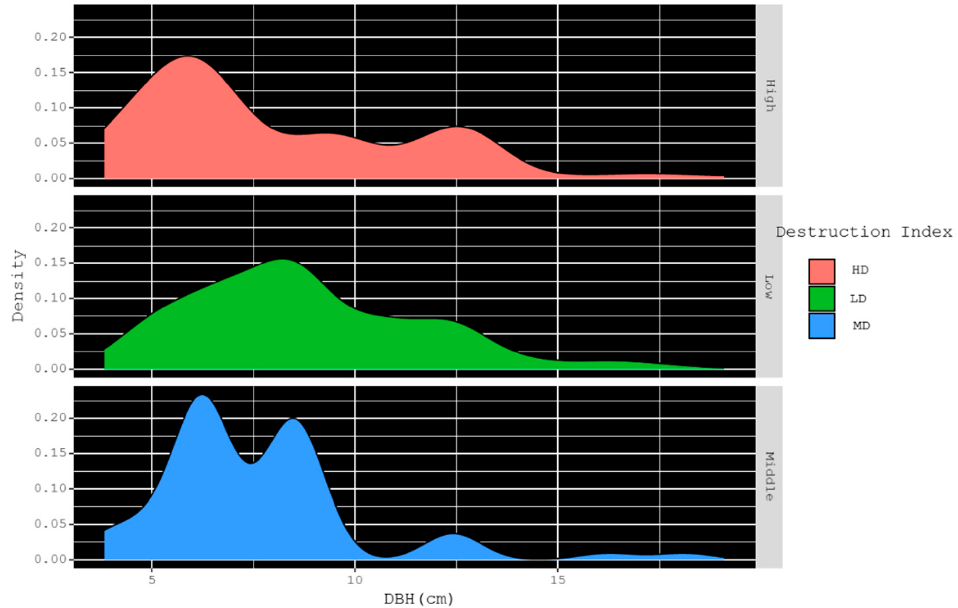
Figure 5. Density frequency distribution of tree size (DBH) by the destruction class in a naturally- regenerated broadleaf forest in the Arasbaran biosphere reserve in Iran ( n = 30). LD = Low Destruction, MD = Medium Destruction, and HD = High Destruction. See Table 2 for description of the destruction class.